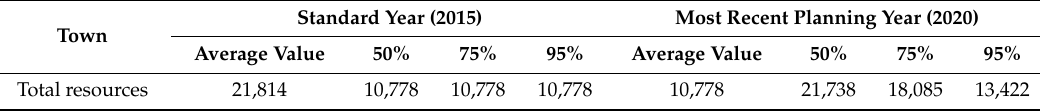
Table 3. Available water supply in different years under different frequencies (unit: 10 4 m 3 ).